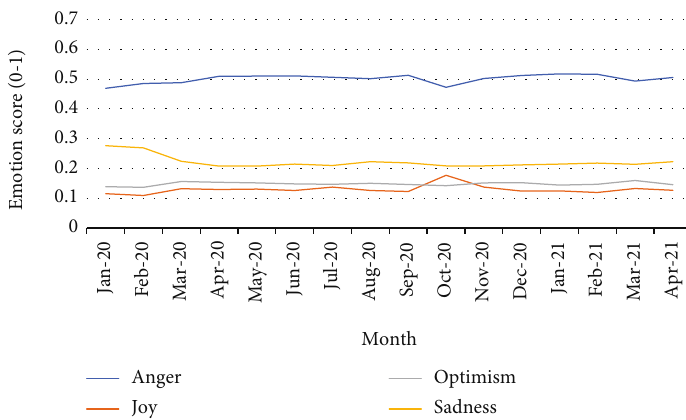
Figure 6: Chart showing monthly average emotion scores across The Guardian ’ s user tweets over time. User tweets are reactions to The Guardian ’ s news tweets shown in Figure 5.